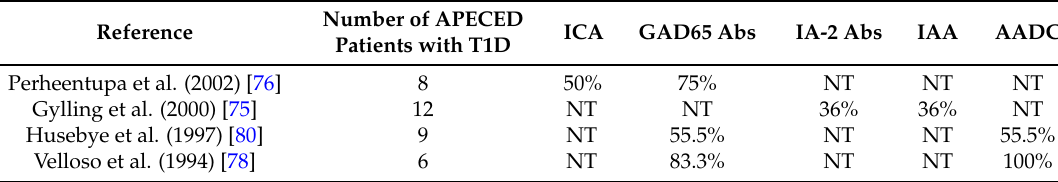
Table 3. Main studies reporting testing of diabetes-related autoantibodies tested in sera of APECED patients affected by